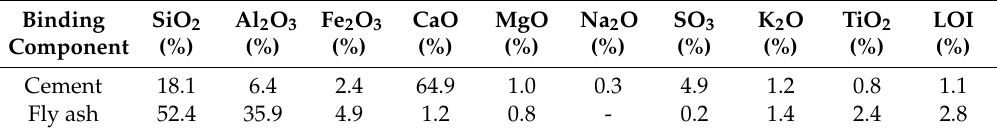
Table 1. Chemical composition and properties of the used binder